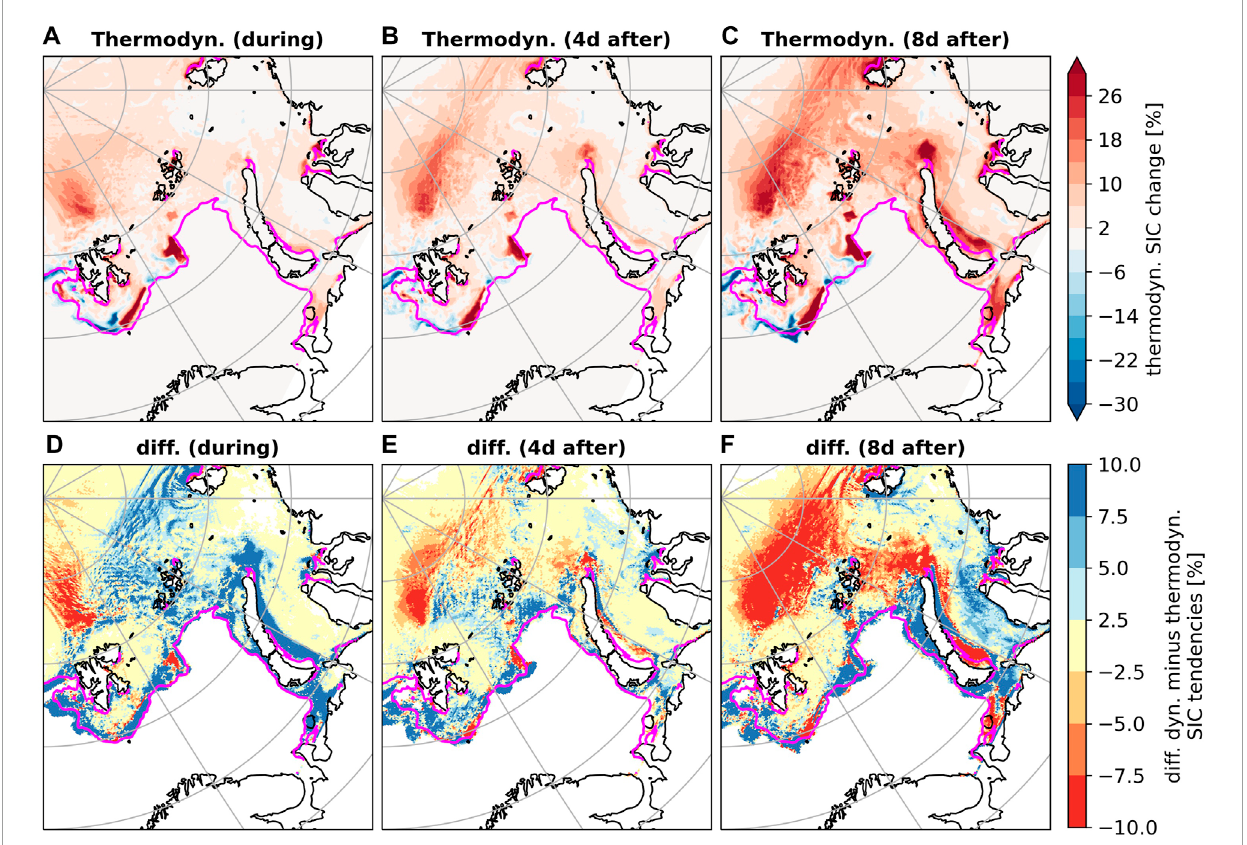
FIGURE 6 Temporally integrated thermodynamic SIC change (A–C) and difference between absolute values of temporally integrated dynamic and thermodynamic SIC change (D–F) during (20.2.—24.2.2020), shortly after (24.2.20—28.2.2020) and for a longer period after (24.2.—3.3.2020) cyclone 3 based on the HIRHAM–NAOSIM simulation. Pink lines indicate the position of the ice edge (15% SIC) at the start of the cyclone